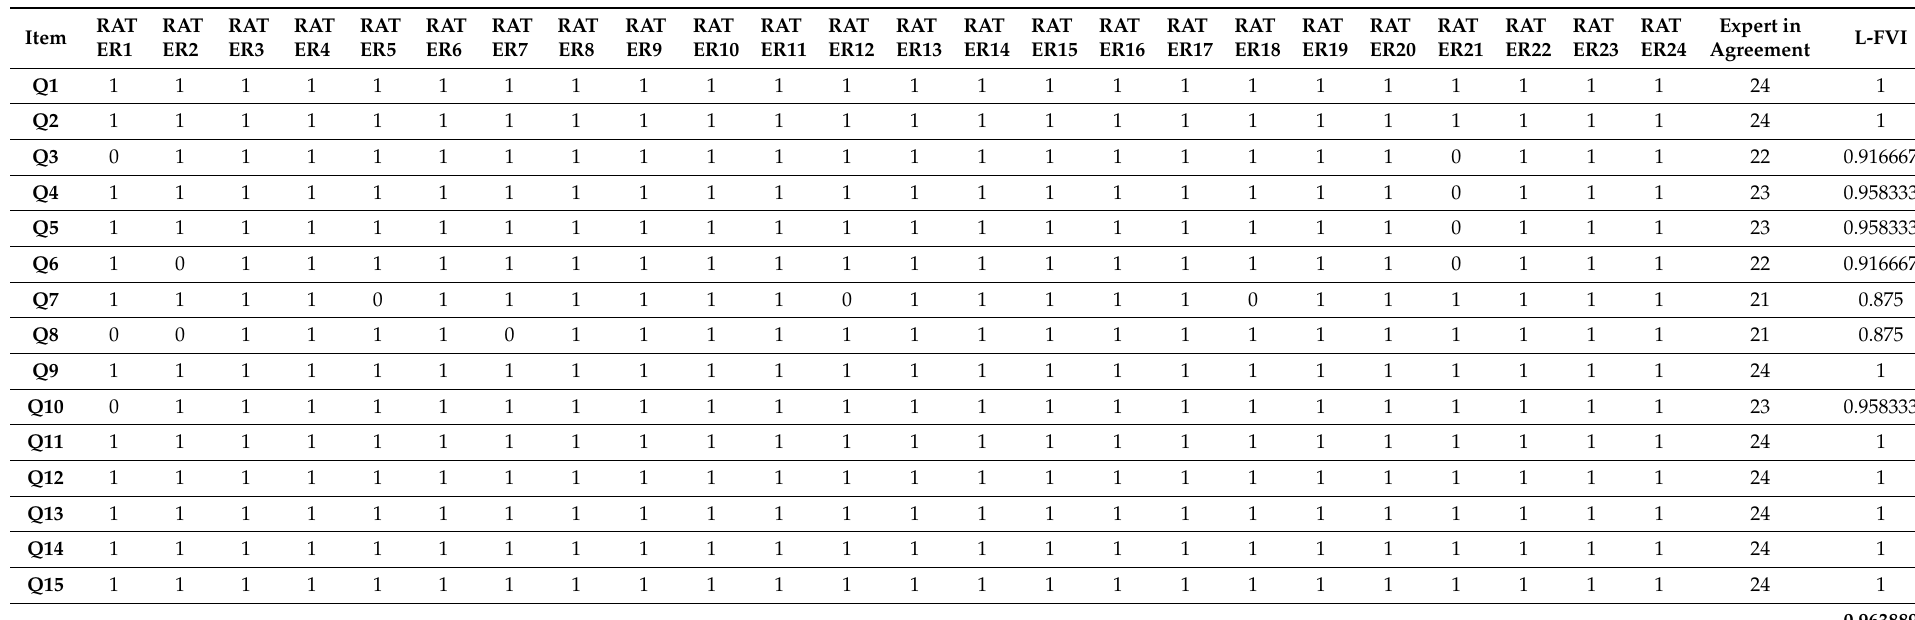
Table A2. Face Validity Index based on the rating of the clarity and comprehensibility of items by 24 target